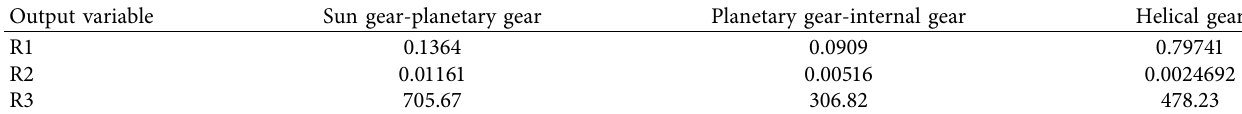
Table 5: Maximum results of finite element